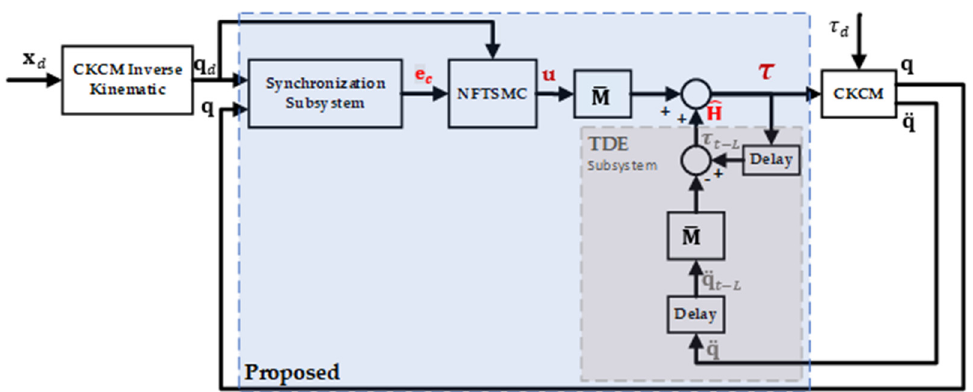
Figure 3. Structure of the Proposed Control Scheme.